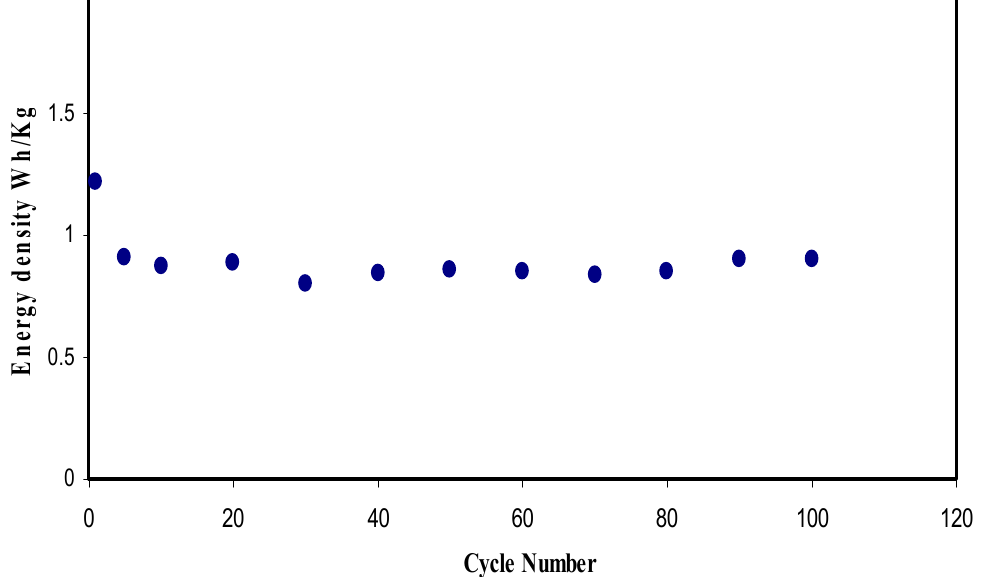
Figure 15. Energy density of the fabricated EDLC for 100 cycles.